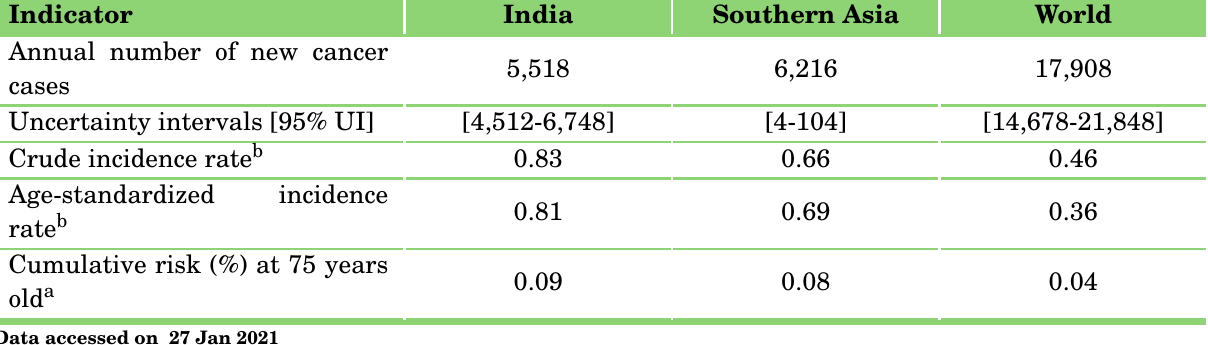
Table 11: Vaginal cancer incidence in India (estimates for 2020)